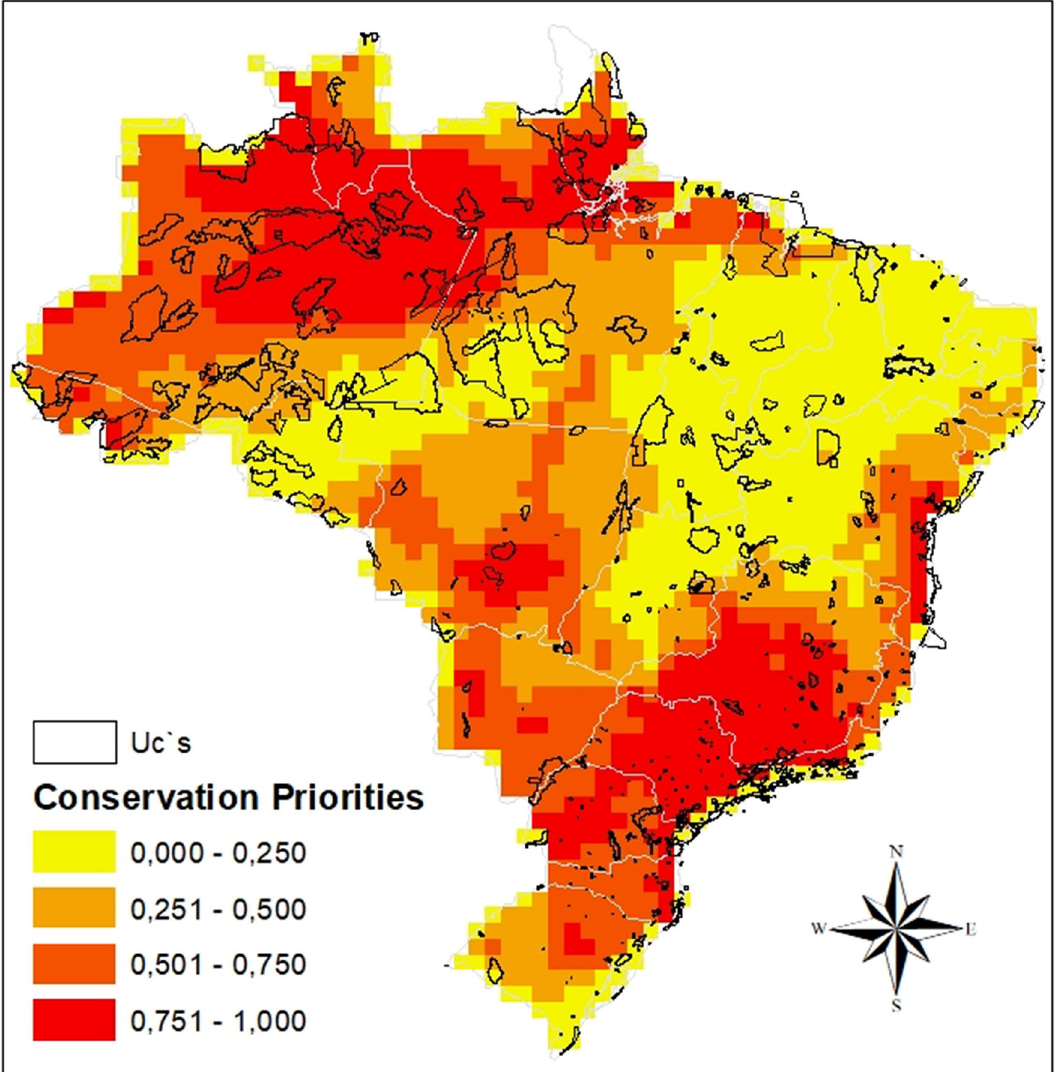
Figure 3. Priority areas for Gerromorpha conservation in Brazil, according to the Zonation algorithm. Values indicate the importance of each cell; the higher the value, the higher the importance. The figure was built on the R environment 63 .